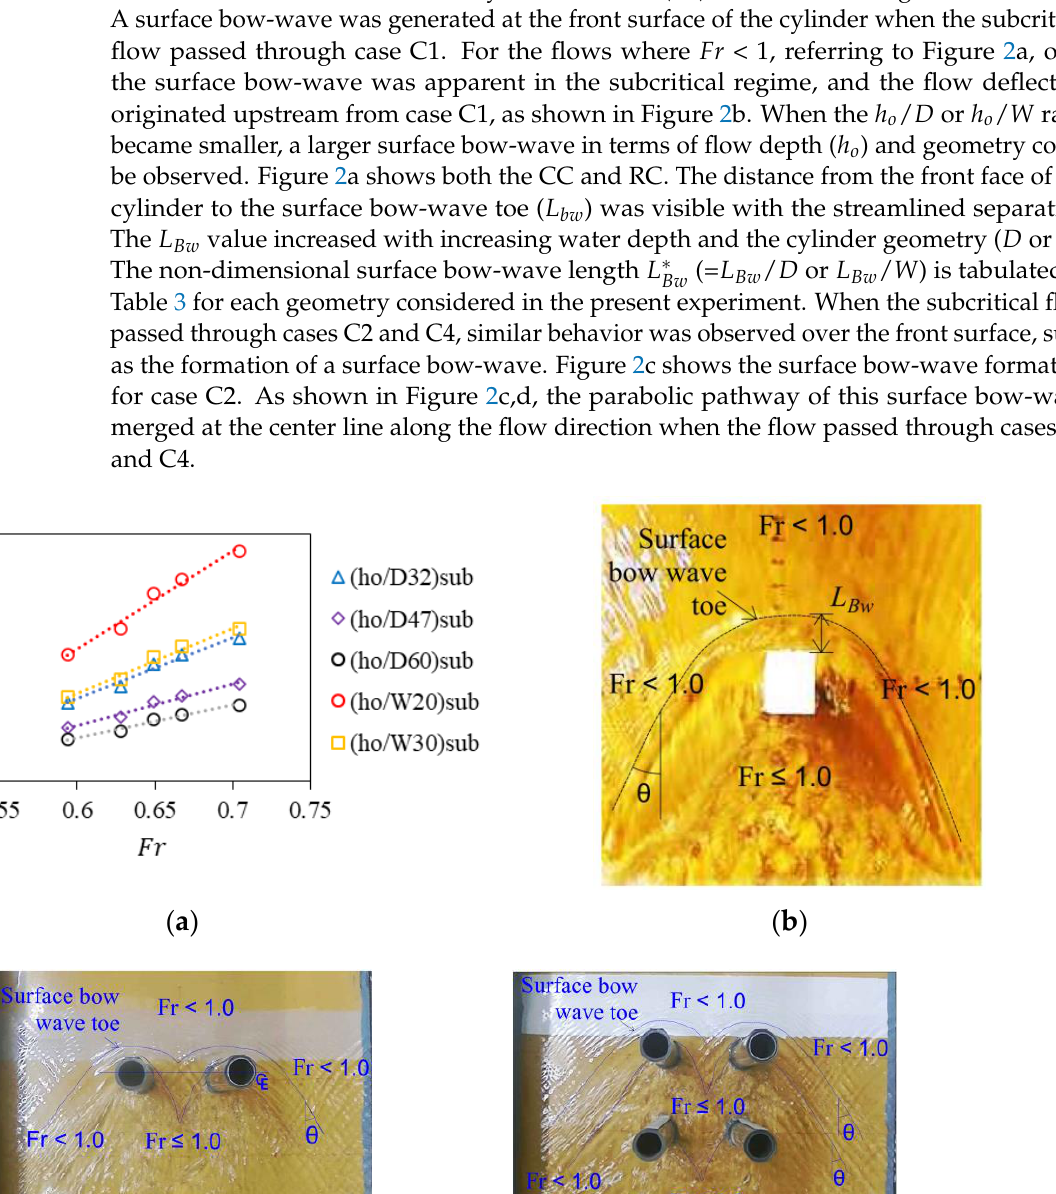
Table 3. Non - dimensional surface bow - wave length.